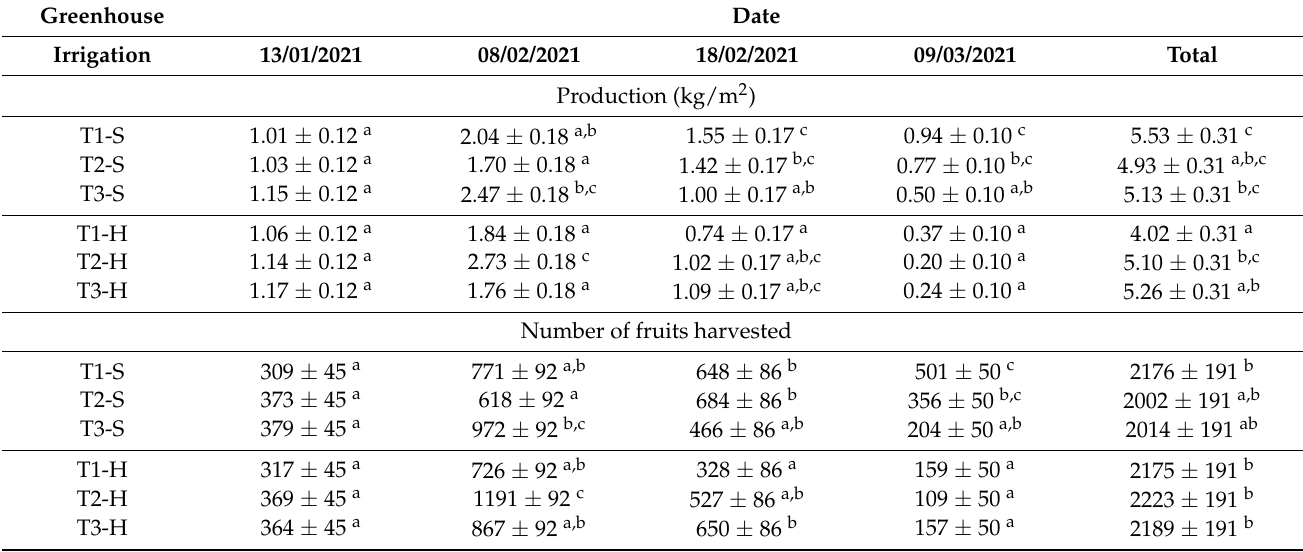
Table 4. Production and fruit at different harvest